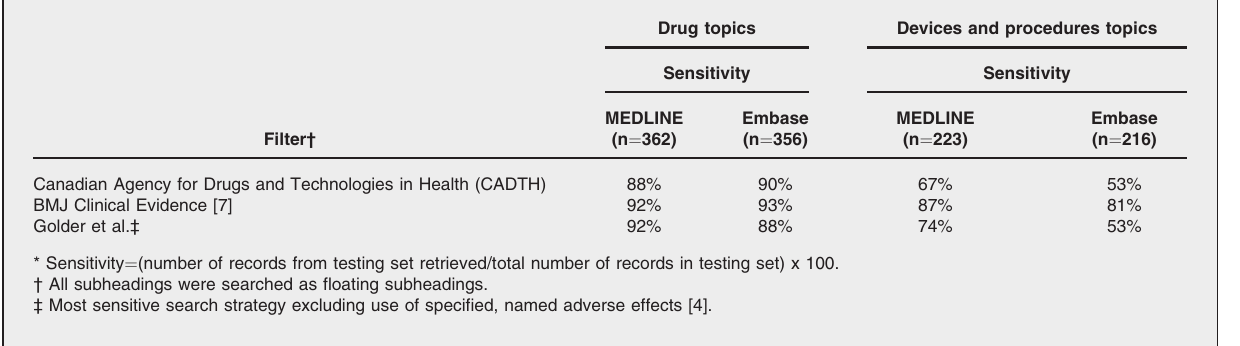
Sensitivity* of adverse effects filters in Ovid MEDLINE and